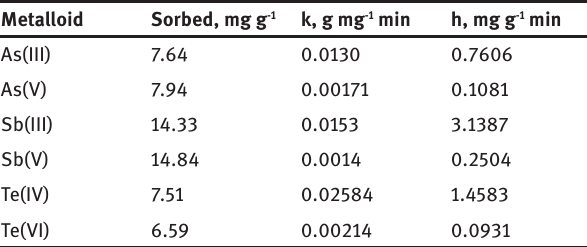
Table 2: Calculated kinetic parameters of Fe-modified peat sorbing metalloids (k – rate constant of sorption, h – the initial sorption rate).